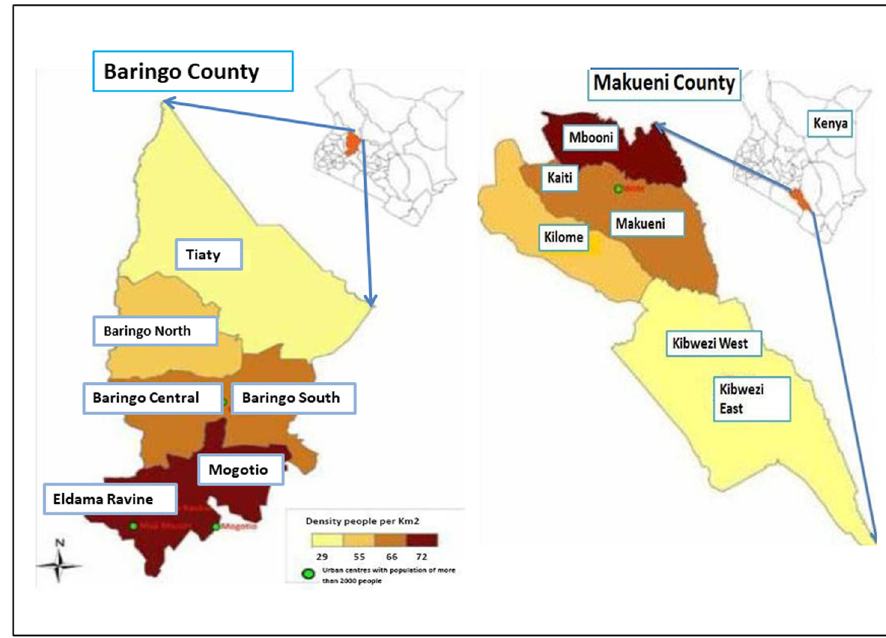
Figure 1: Map of the study areas ( Makueni and Baringo Counties, Kenya )